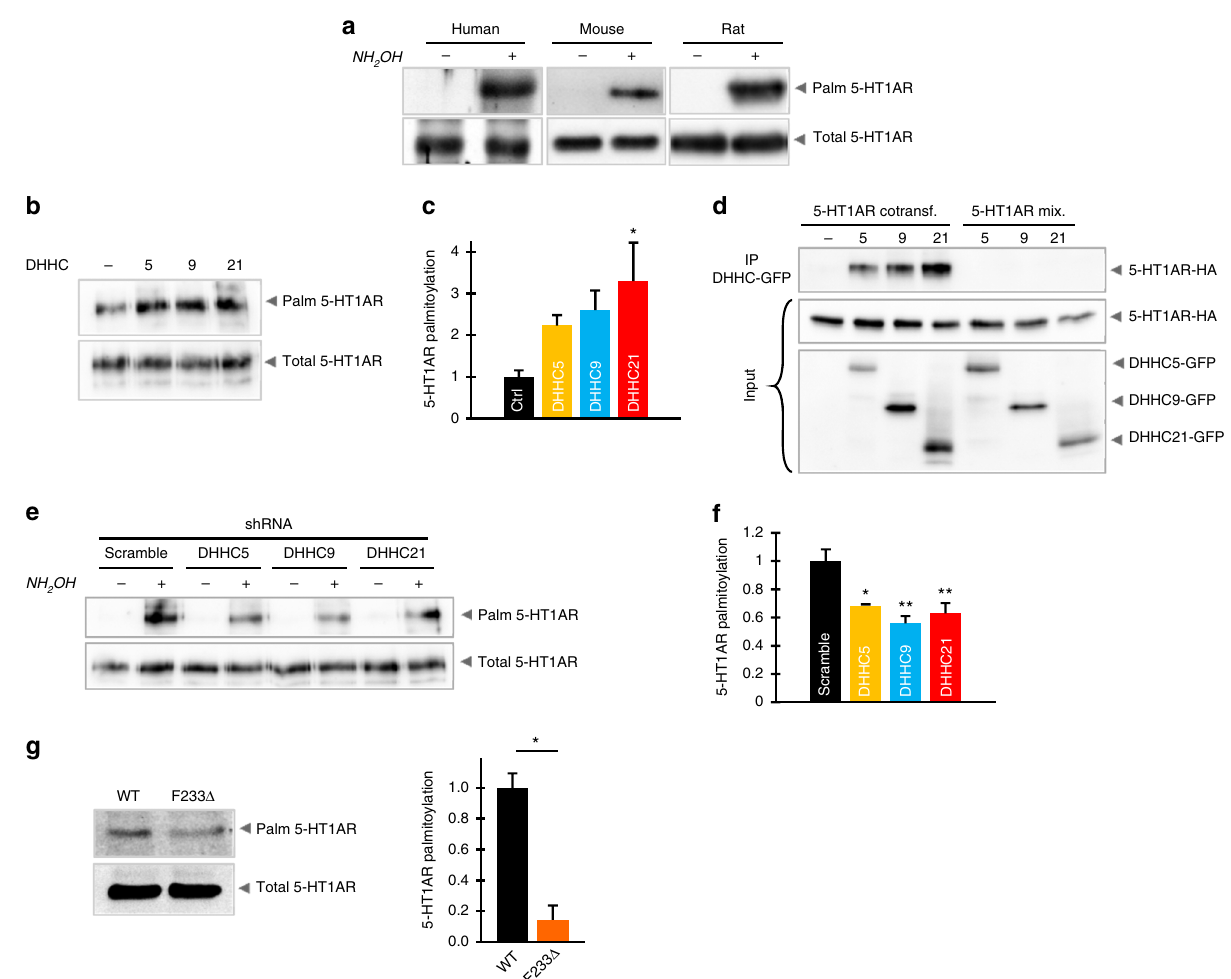
Fig. 1 Endogenous 5-HT1AR is palmitoylated in rodent and human brains and ZDHHC21 is a major receptor palmitoyl acyltransferase. a Palmitoylation of endogenous 5-HT1AR in human, mouse, and rat brains was assessed by the acyl-biotinyl exchange (ABE) assay (see also Supplementary Fig. 1B). b Neuroblastoma N1E cells co-expressing 5-HT1AR and indicated ZDHHCs were analyzed by ABE (see also Supplementary Fig. 2A, B). c Quanti fi cation of 5-HT1AR palmitoylation after co-expression of ZDHHC5, -9, and -21 ( n = 5). d N1E cells were co-transfected with hemagglutinin (HA)-tagged 5-HT1AR and indicated green fl uorescent protein (GFP)-tagged ZDHHCs, followed by immunoprecipitation (IP) with anti-GFP antibody and western blot with anti- HA antibody. As a control, mixed lysates from the singly transfected cells (mix) were applied to IP. e Analysis of 5-HT1AR palmitoylation in N1E cells after knockdown of endogenous ZDHHC5, -9, and -21 by short hairpin RNA (see also Supplementary Fig. 3A – E) together with f quanti fi cation. Western blots shown in e are representative of at least four independent experiments. g Brain tissues isolated from the newborn (P0) F233 Δ Zdhhc21 dep/dep ( n = 7) and wild-type ( n = 6) mice were collected for ABE analysis followed by quanti fi cation (see also Supplementary Fig. 3E – H). Bars show means± SEM; * P < 0.05; ** P < 0.01; one-way analysis of variance for c , f ; two-tailed t test for g . Source data are available as a Source Data fi le